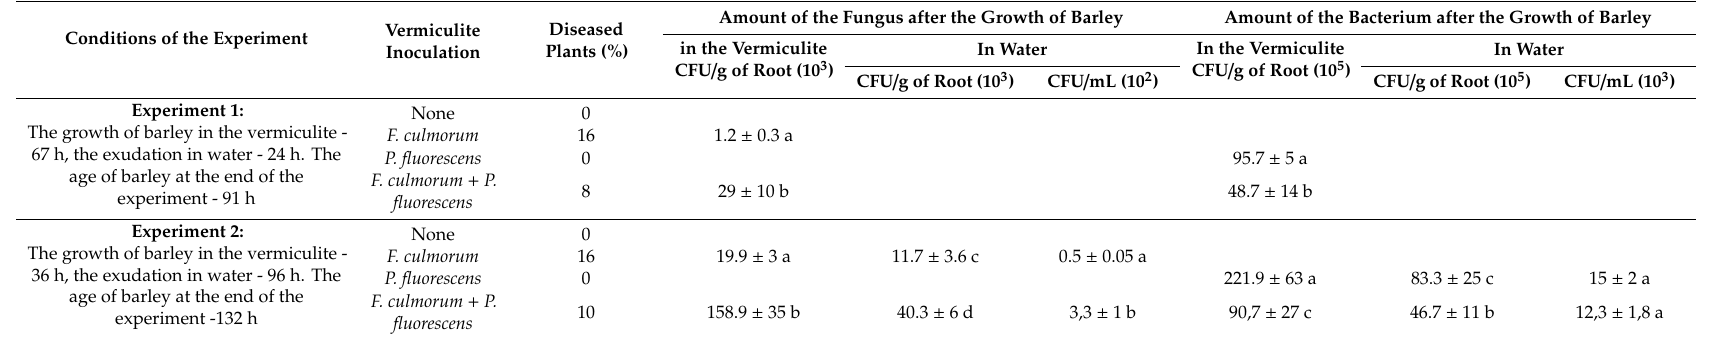
Table 1. Barley disease incidence and the amount of Fusarium culmorum and Pseudomonas fluorescens in the roots and in